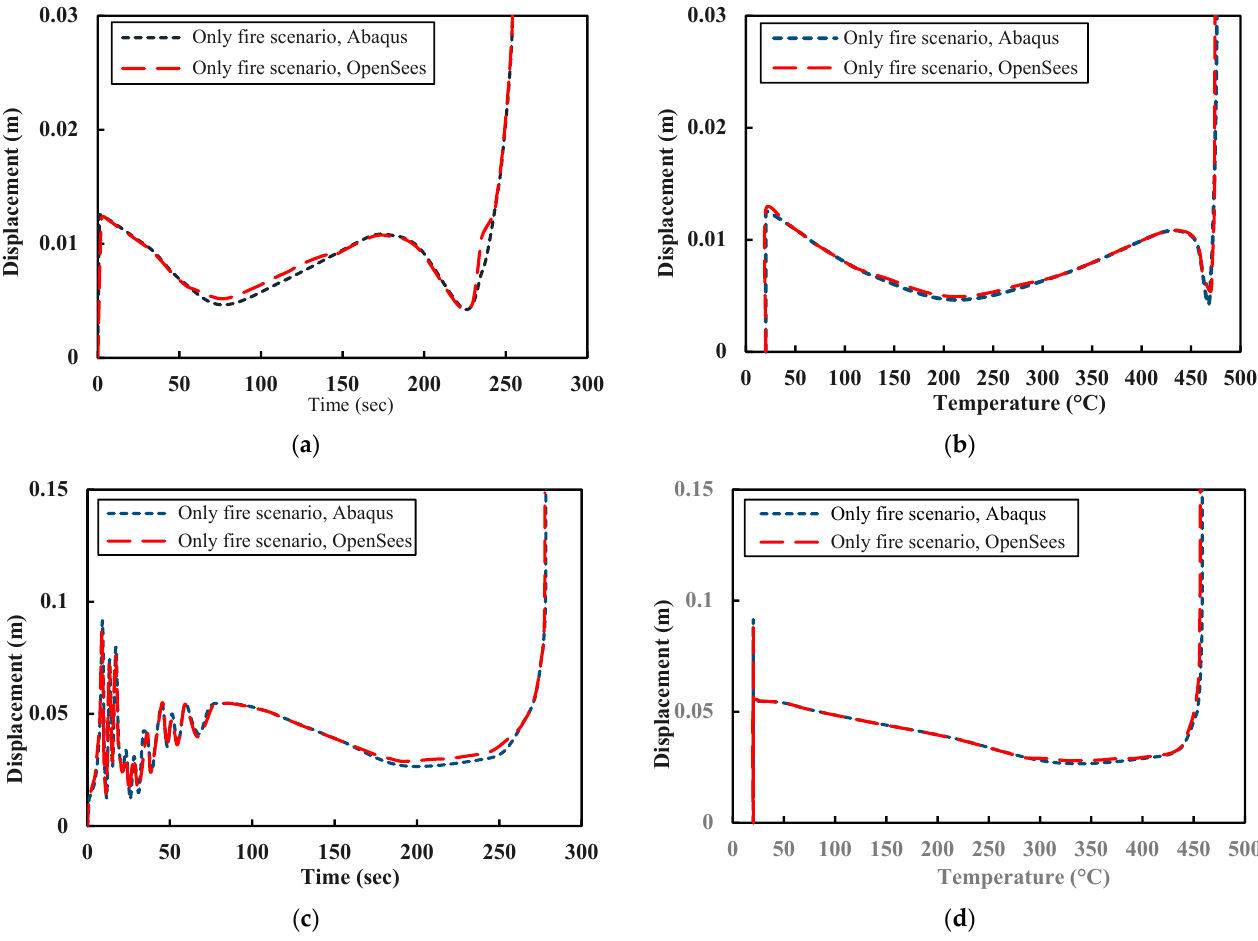
Figure 7. Comparison of Abaqus with OpenSees simulations, including ( a ) the time-displacement record for the fire-only scenario, ( b ) the temperature-displacement record for the fire-only scenario, ( c ) the time-displacement record for the PEF scenario, and ( d ) the temperature-displacement record for the PEF scenario.